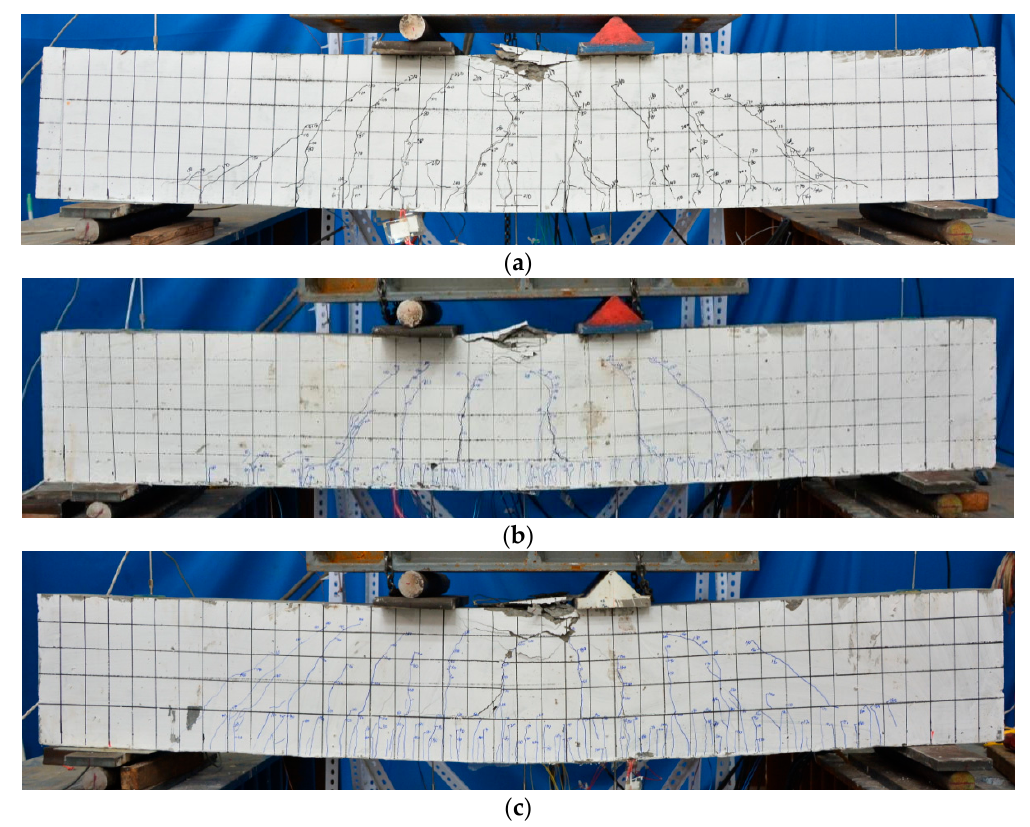
Figure 7. Failure modes of three test specimens: ( a ) RC beam; ( b ) BE1; ( c ) BE2.